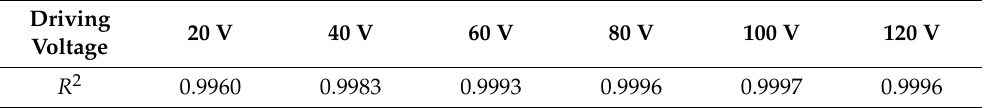
Table 3. Fitting degree of excellence in MPI.